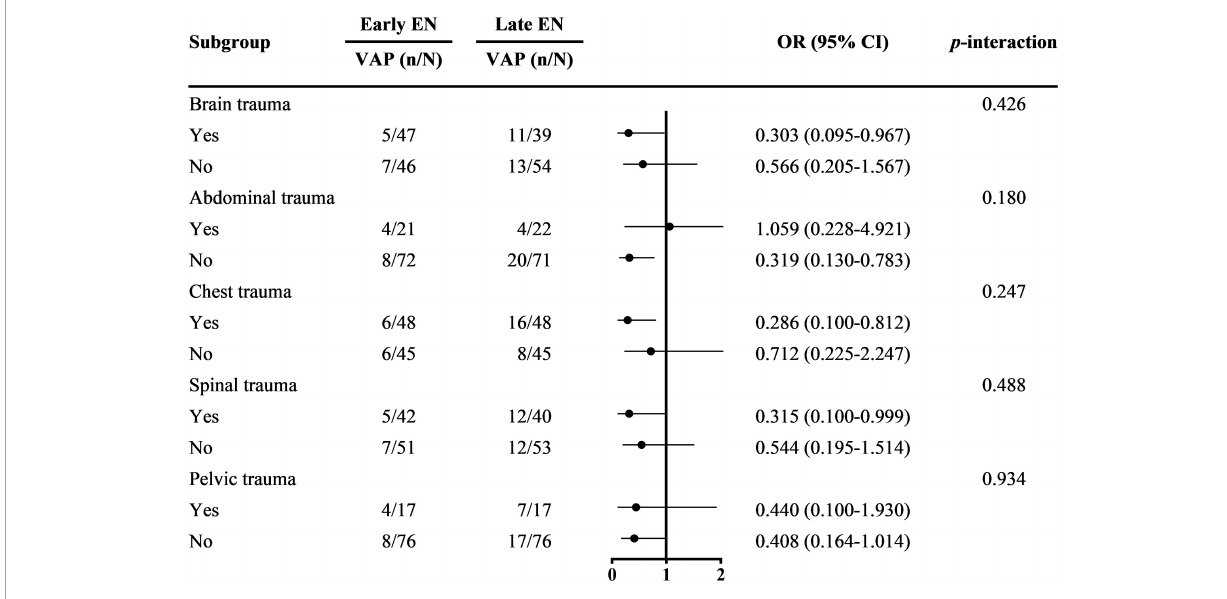
FIGURE2 Treatment effect on VAP by subgroup. VAP, ventilator-associated pneumonia; EN, enteral nutrition; OR, odds ratio; CI, confidence interval.